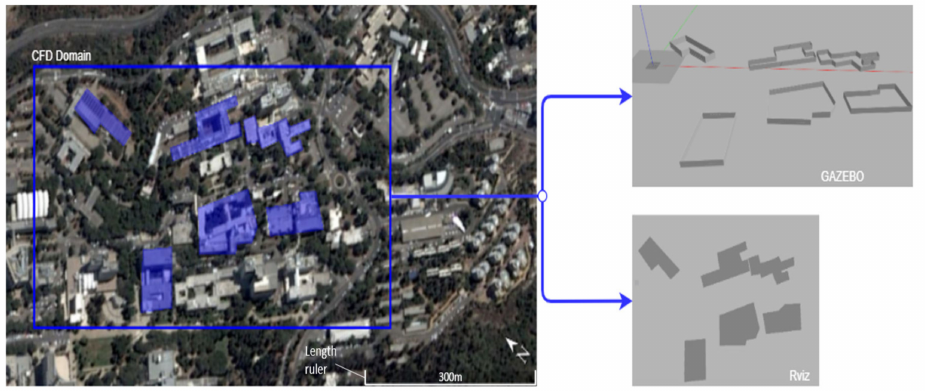
Figure 2. The six-building environment simulated in GRAL, Gazebo, and